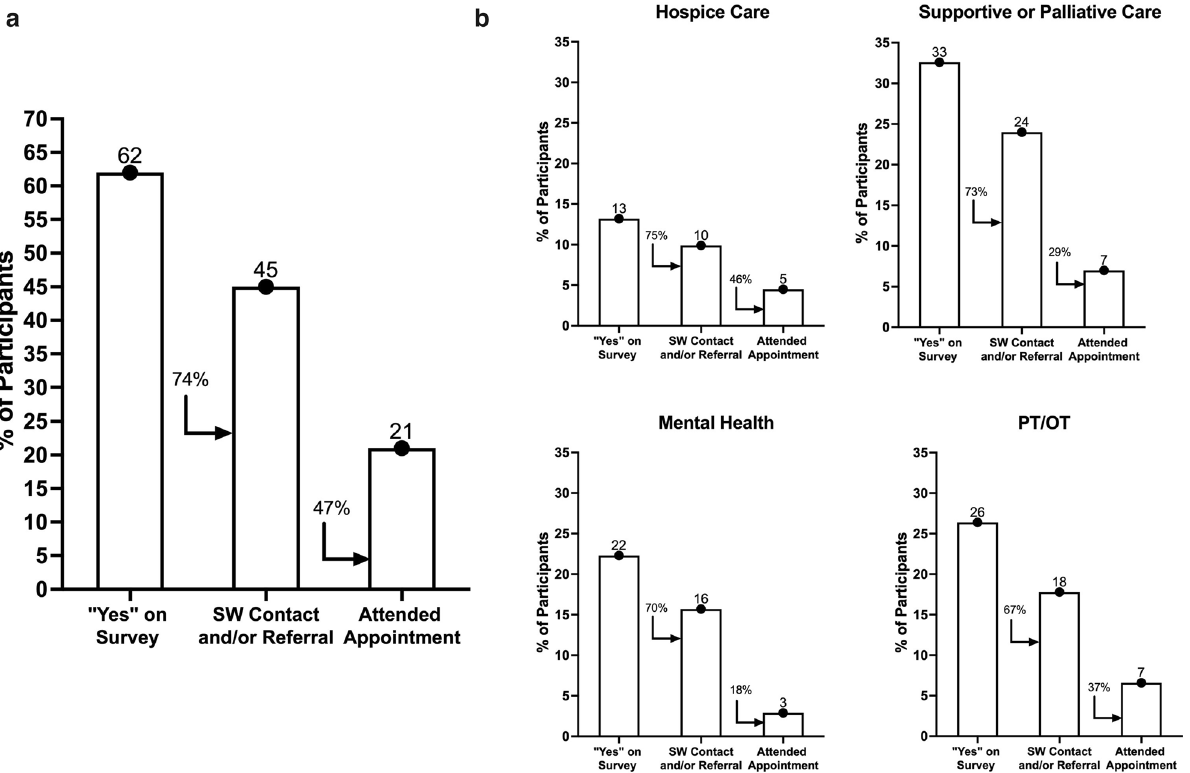
Figure 2. Care cascade after intervention. Summary of the progression of care after a positive response on a screening survey for ( a ) all participants and ( b ) for specific responses.